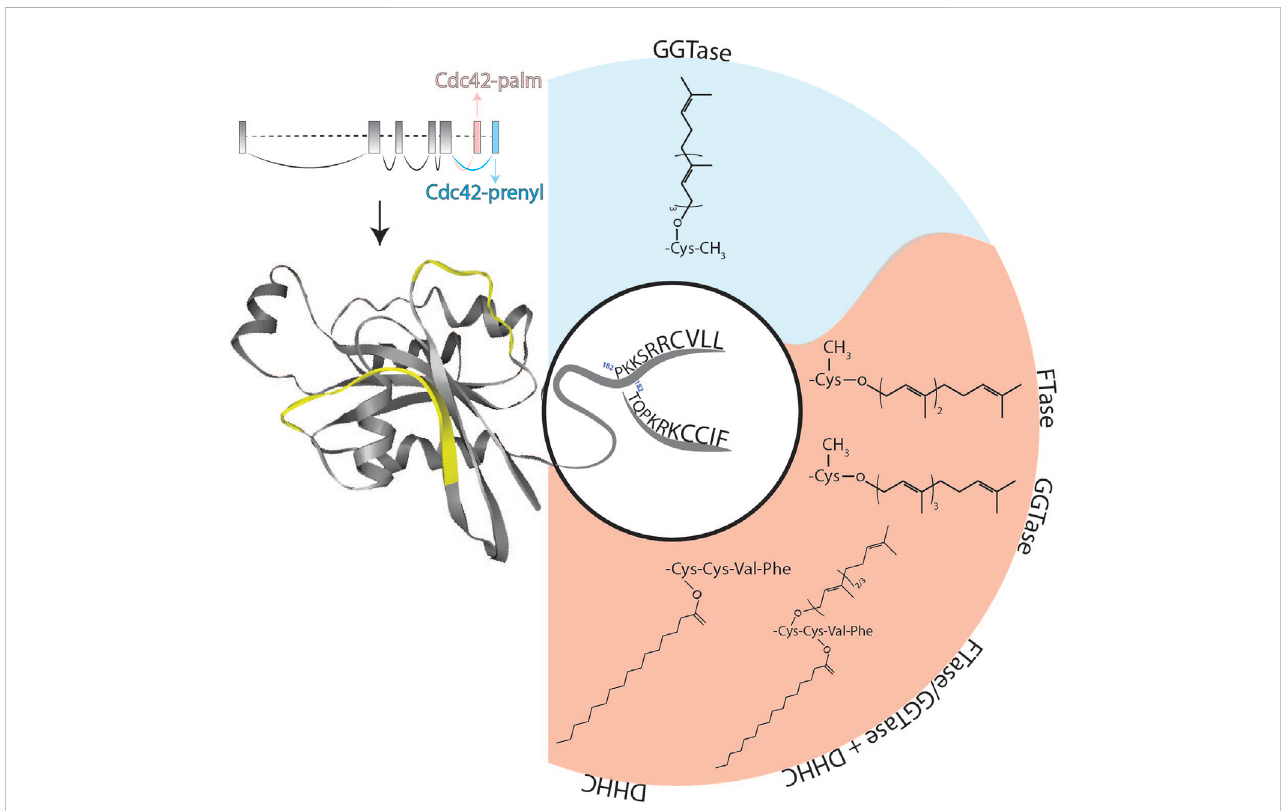
Schematic representation of the structure of Cdc42 alternatively spliced exons as well as protein and its lipid modi fi cations. Two fl exible switch regions are highlighted in yellow. The two different C-termini of Cdc42-palm (red background) and Cdc42-prenyl (blue background) isoforms together with their possible post-translational lipid modi fi cations are shown. DHHC, palmitoyl acyl-transferase harboring a cysteine-rich domain containing a conserved DHHC (Asp-His-His-Cys) motif; FTase, farnesyltransferase; GGTase,